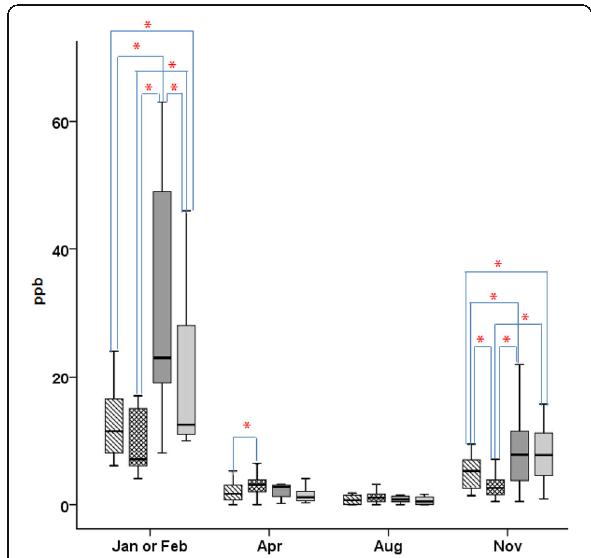
Fig. 3 Comparison of the outdoor NO 2 concentrations in each district in each season. District A: box with stripes, district B: mesh box, district C: black box, district D: gray box; Asterisk indicates statistically significant ( p < 0.05); air quality standard for the mean annual. NO 2 concentration: 30 μ g/m 3 (16